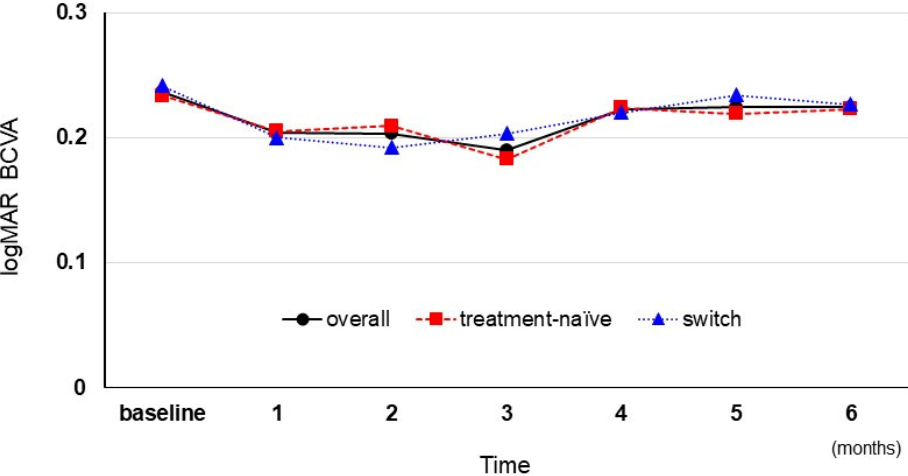
Figure 1. The mean logMAR BCVA changes following intravitreal faricimab injection. logMAR, the logarithm of the minimum angle of resolution; BCVA, best-corrected visual acuity.